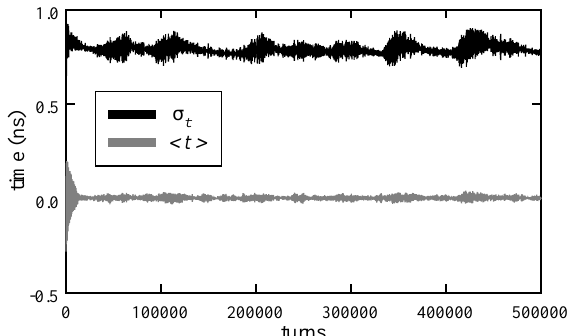
FIG. 3. Simulation of coupled-quadrupole Robinson instability for passive Landau-cavity operation with the Aladdin lattice, for a ring current of 200 mA and Landau-cavity tuning angle of 2 85 ± .